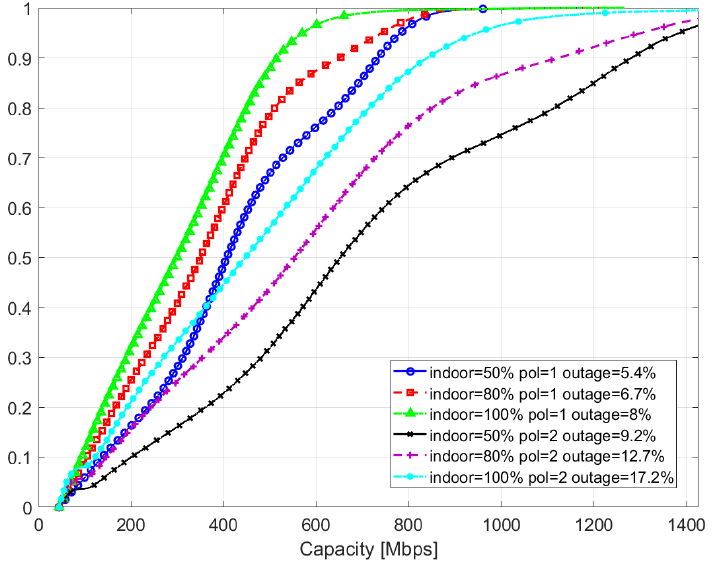
Figure 11. CDF of UT rates for different user indoor percentages, N t = 144 with N ty = 36, N tz = 4, N r = 2, P TX = 47 dBm, traffic density = 2500 users/km 2